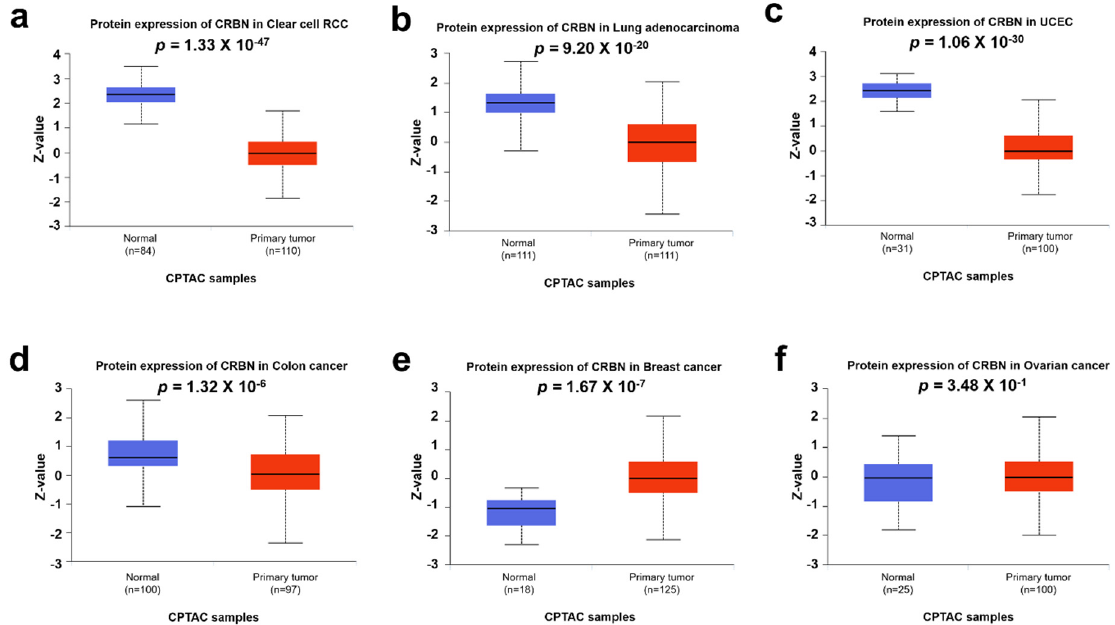
Figure 4. CRBN protein expression in various cancer types. CRBN expression in each type of cancer and normal tissues were explored in ( a ) clear cell renal cell carcinoma (RCC), ( b ) lung adenocarcinoma (LUAD), ( c ) uterine corpus endometrial carcinoma (UCEC), ( d ) colon cancer, ( e ) breast cancer, and ( f ) ovarian carcinoma based on the Clinical Proteomic Tumor Analysis Consortium (CPTAC) Confirmatory/Discovery dataset using the UALCAN web tool. Z-values represent standard deviations from the median across samples for each given cancer type.